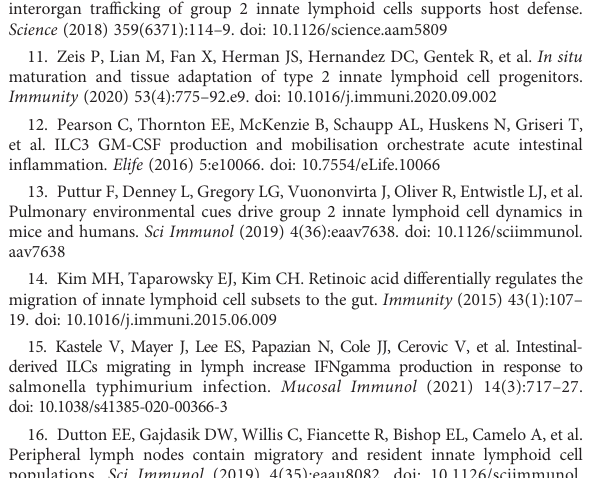
SUPPLEMENTARY TABLE 1 List of antibodies used for fl ow cytometry. SUPPLEMENTARY TABLE 2 Genes in each human ILC cluster from the spleens of HSPC-engrafted MISTRG mice as de fi ned by single-cell